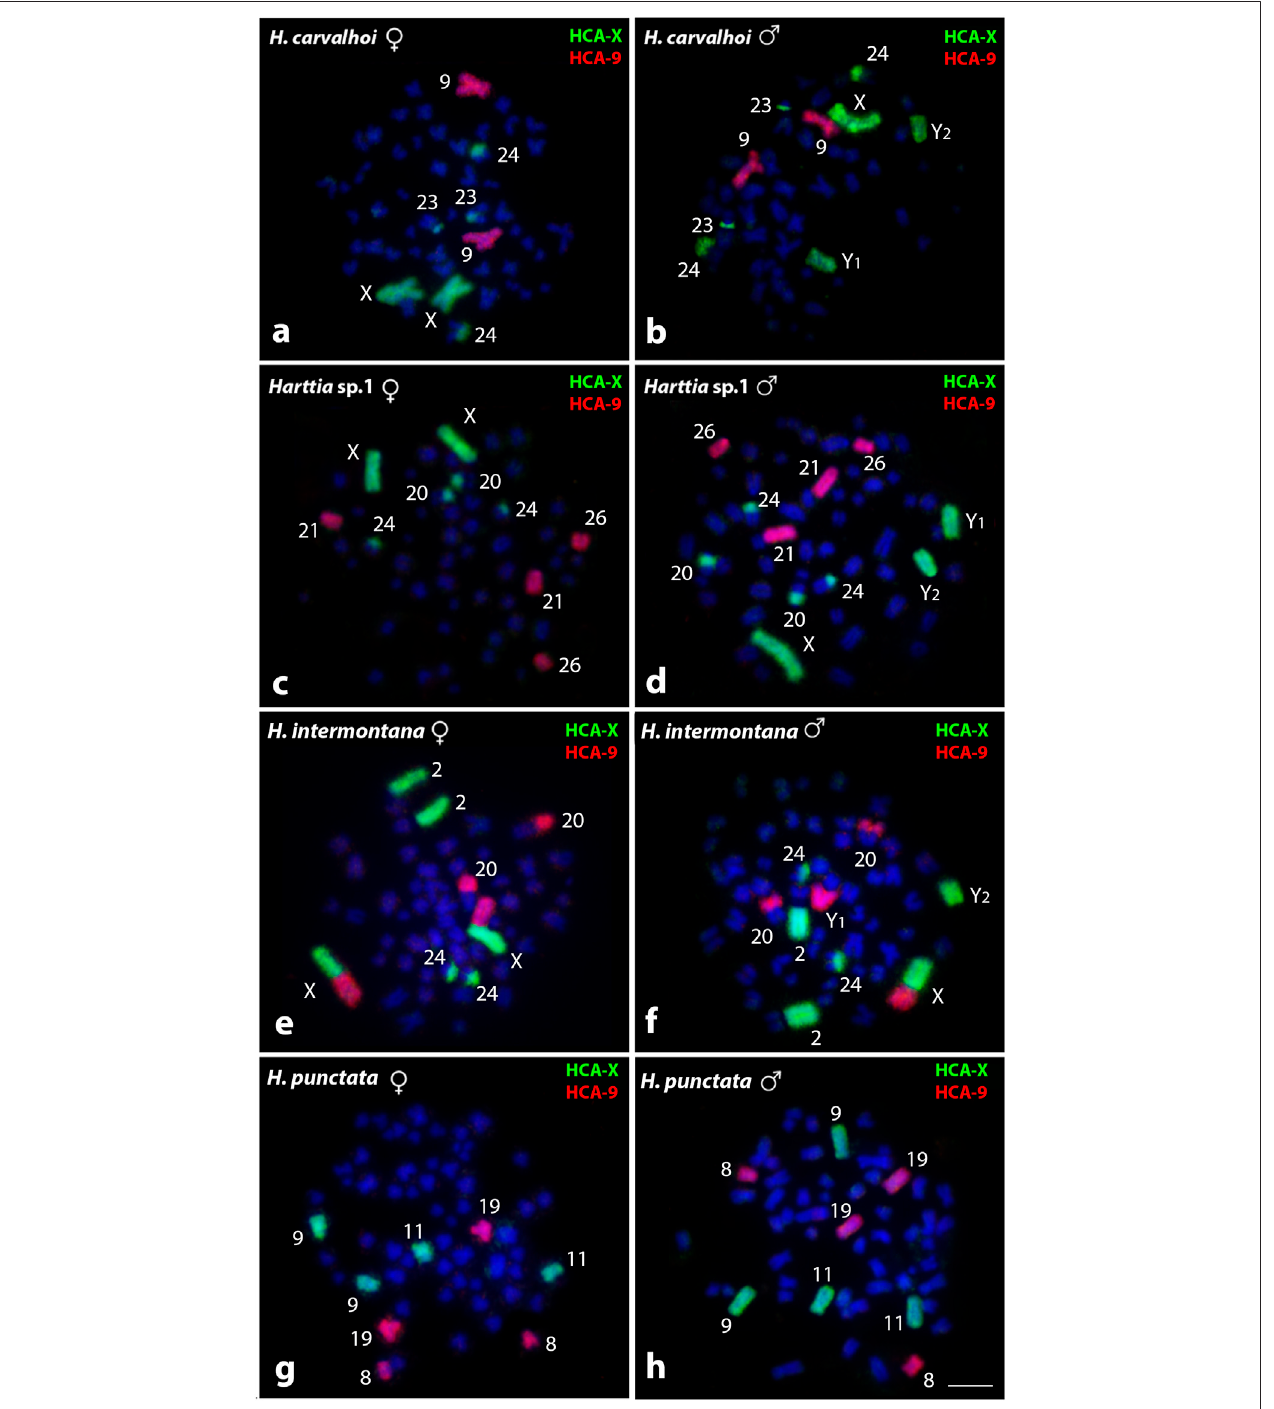
FIGURE 2 | Whole chromosome painting by FISH using HCA-X (green) and HCA-9 (red) probes among Harttia species that possess SCSs. The numbers of the labeled chromosome pairs are highlighted in the images. In (A, B) metaphases of H. carvalhoi female and male, respectively; (C, D) metaphases of Harttia sp. 1 female and male, respectively; (E, F) metaphases of H. intermontana female and male, respectively; and (G, H) metaphases of H. punctata female and male, respectively. Bar = 5 µm.